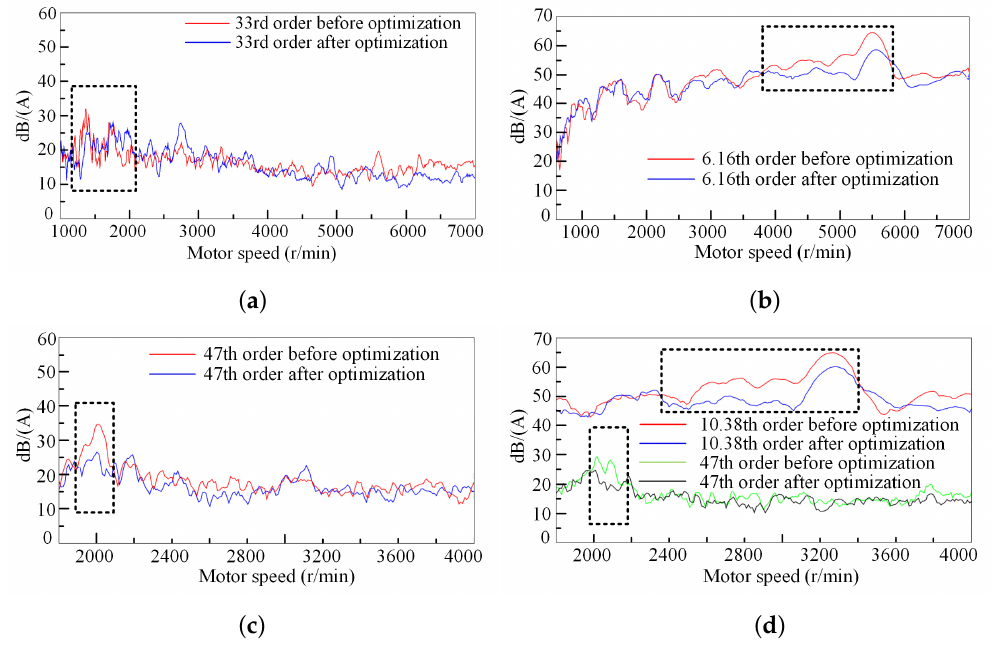
Figure 19. ( a ) Comparison of 33rd order noise before and after optimization. ( b ) Comparison of 6.16th order noise before and after optimization. ( c ) Comparison of 47th order noise before and after optimization. ( d ) Comparison of 10.38th and 47th order noise before and after optimization.